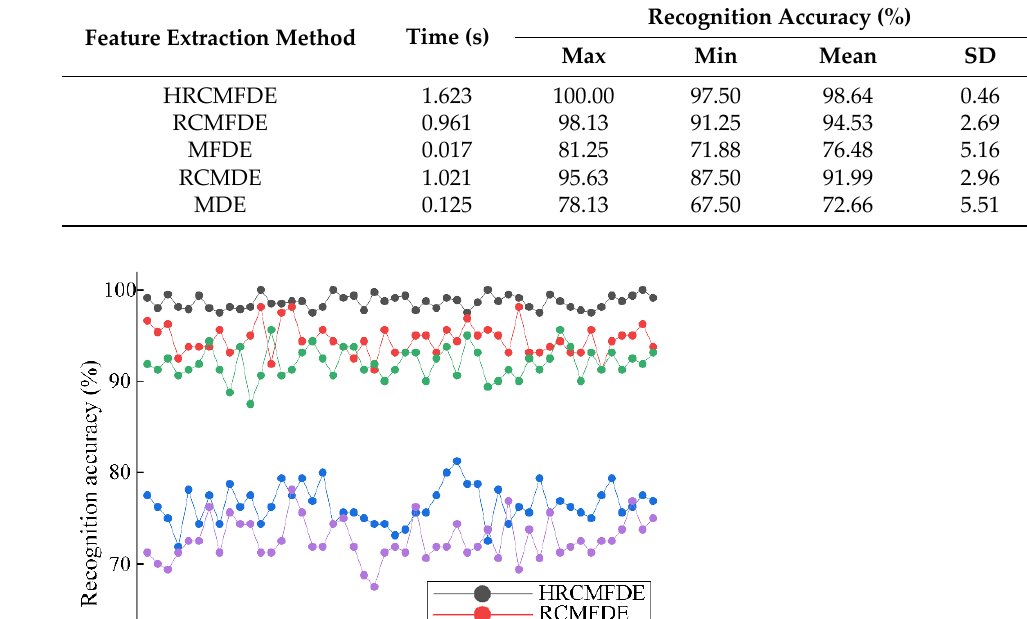
Table 3. The performance comparison between different feature extraction models. Feature Extraction Method